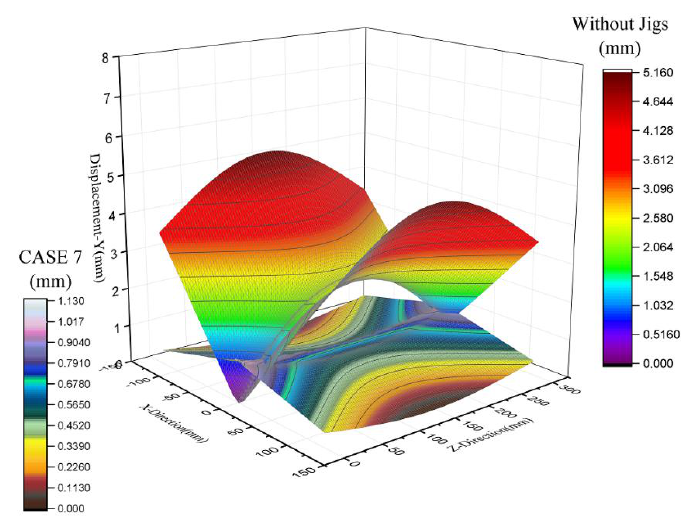
Figure 19. Three-dimensional (3D) image of welding deformation without jigs in CASE 7.